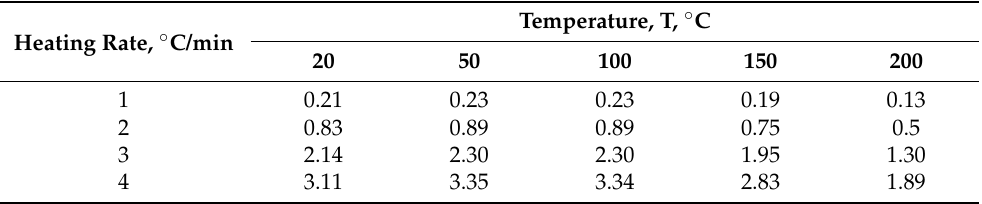
Table 5. Dependence of deflection of the panel (150 × 150 mm) on the rate of temperature change, mm. Heating Rate, ◦